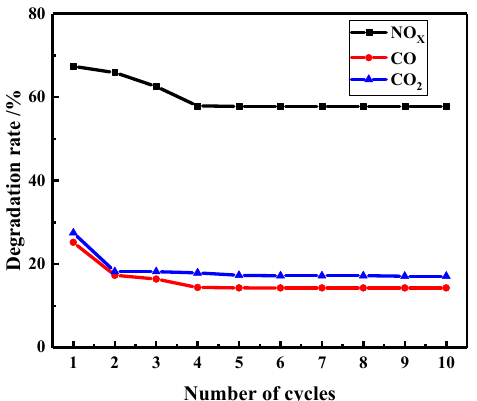
Figure 11. The reusability for VE degradation performance of photocatalytic coating.